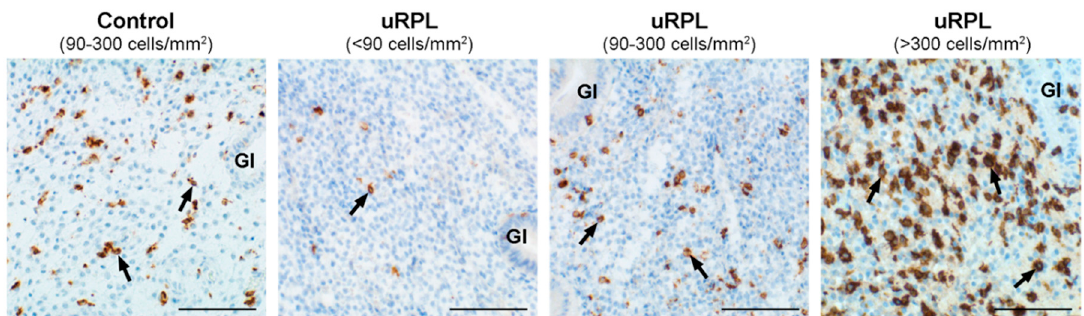
Figure 2. Immunohistochemical localization of CD56 + cells (arrows) in the endometrium of the control (90–300 cells / mm 2 ), uRPL-CD56 Low ( < 90 cells / mm 2 ), uRPL-CD56 Normal (90–300 cells / mm 2 ), and uRPL-CD56 High subgroups ( > 300 cells / mm 2 ). Gl: endometrial glands. Scale bar = 100 µ m.